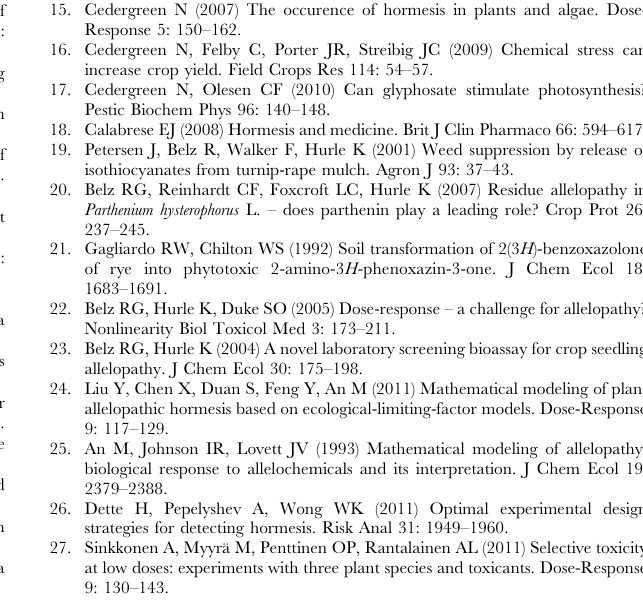
Table S4 Regression Parameters for curves displayed in Figure 2. Table S5 Relative bias (%) between effective dosages estimations from curves displayed in Figures 2, 3, and 4. Table S6 Regression Parameters for curves displayed in Figure 3. Table S7 Regression Parameters for curves displayed in Figure